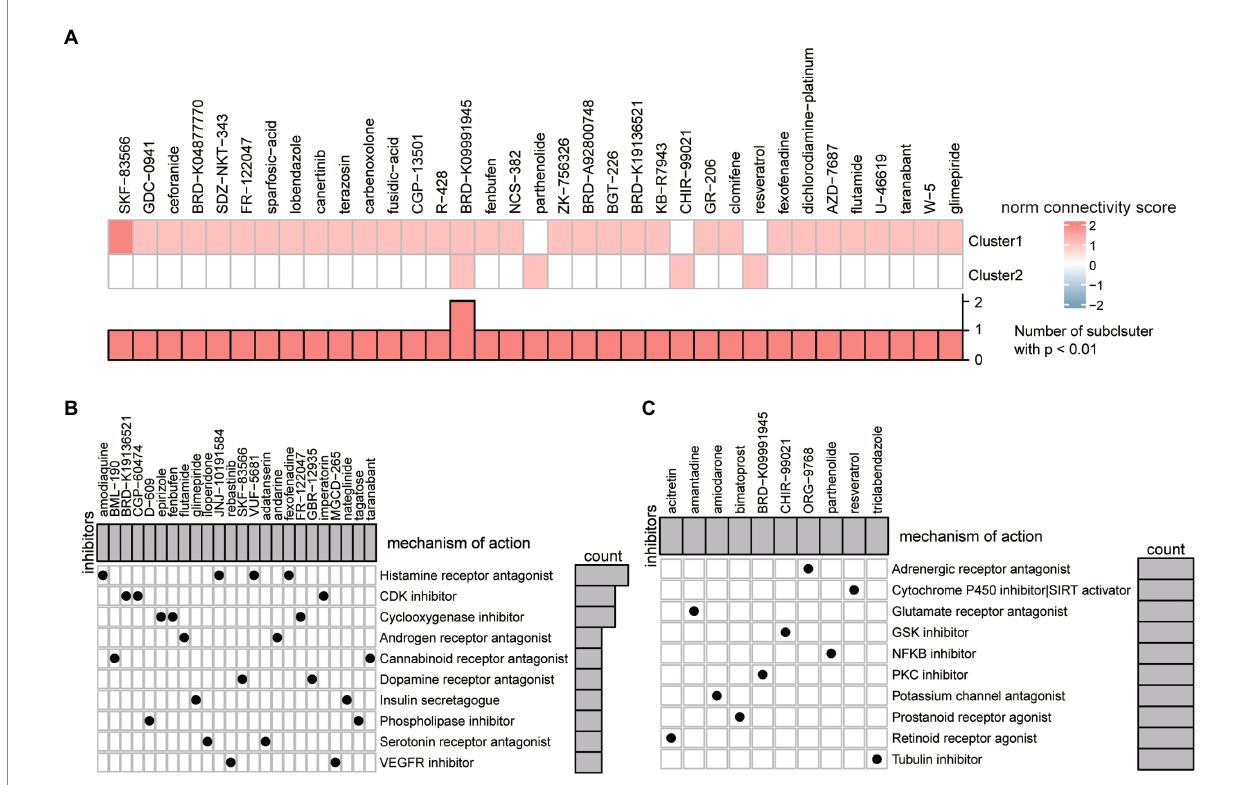
FIGURE 10 The potential compounds target different ER stress patterns. (A) Heatmap showing the scaled connectivity score of each compound for different ER stress patterns. (B,C) Heatmap displaying the mechanisms of action shared by prospective therapeutic compounds for cluster 1 (B) and cluster 2 (C) ,